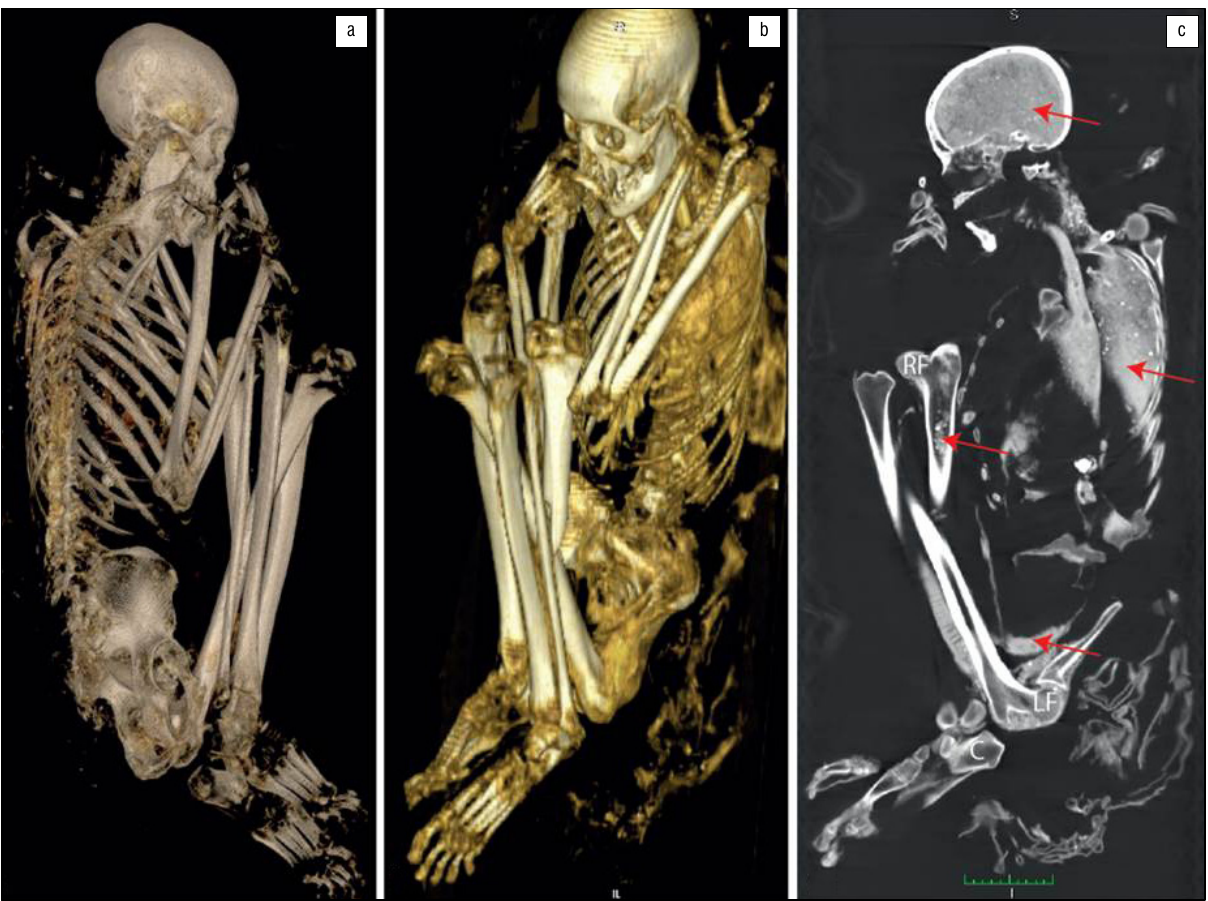
Arrows, soil/stones in cranial and thoracic cavity and pelvis; C, left calcaneal bone; LF, left femoral head; RF, right distal femur in reverse position. Figure 2: (a) Three-dimensional volume rendering, (b) maximal intensity projection and (c) sagittal slice of the Tuli